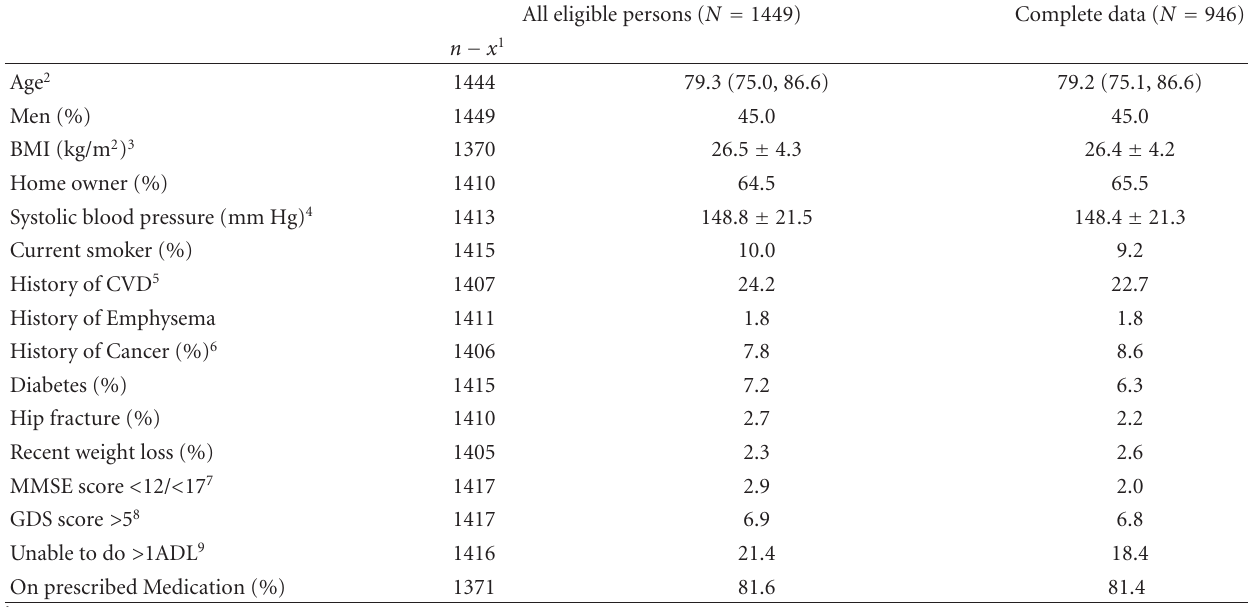
Table 1: Characteristics of all persons in the PA study and of those with full data.